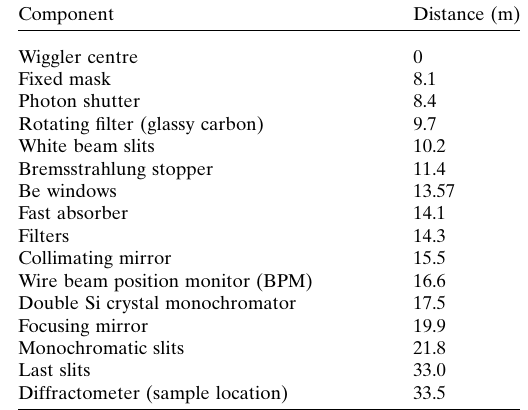
Table 2 The main components of the beamline and their corresponding distances from the wiggler centre.